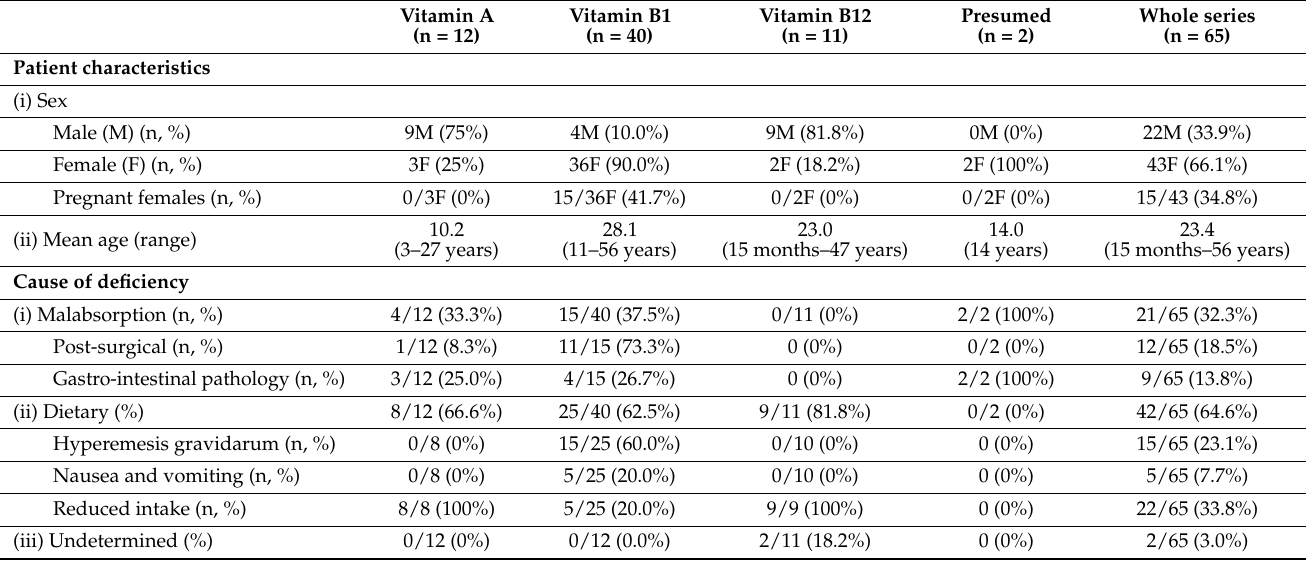
Table 2. Patient characteristics and causes of nutritional deficiencies.